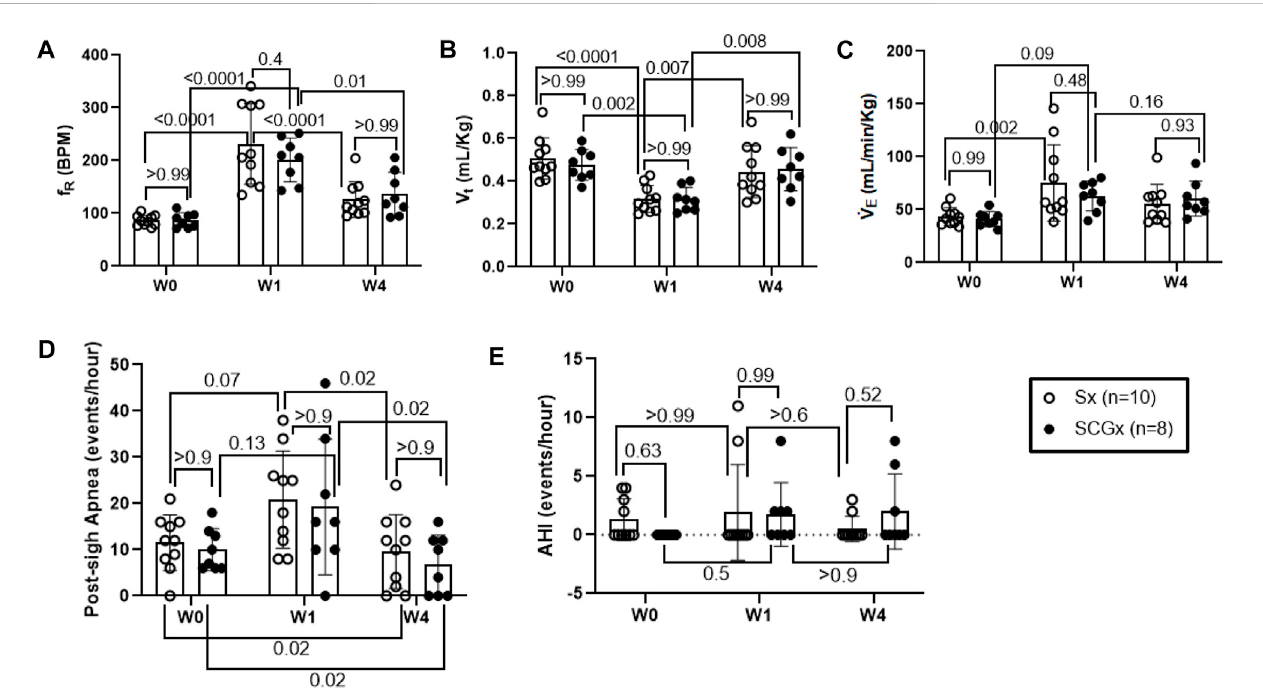
FIGURE 4 Effect of Sx (n = 10) and SCGx (n = 8) on resting ventilatory parameters- (A) Respiratory rate (f R ); (B) Tidal volume (V t ); (C) Minute ventilation (V _ E ) and, (D) Post-sigh Apneas and (E) Apnea-hypopnea Index (AHI) in bleo rats at W1 and W4 post-bleo. Two-way ANOVA was applied using Bonferroni multiple comparisons, Values are mean ±